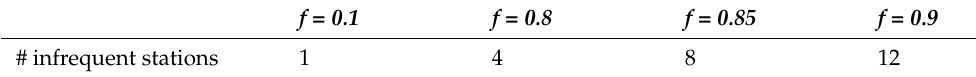
Table 6. Number of filtered infrequent stations with variable f and fixed varianceThreshold =